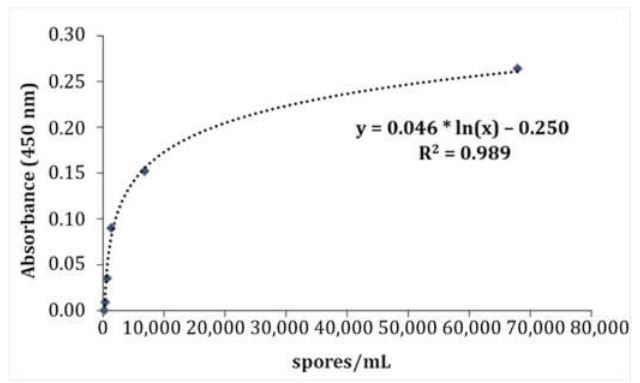
Figure 3. Standard curve developed from fresh B. cinerea conidia, obtained from the relation be- tween conidia concentrations and the generated absorbance values. Dark blue points represent the absorbance value of each concentration point (in spores/mL). Discontinuous line represents the logarithmic curve to which data fitted, defined by the mathematical expression presented in the chart (y, R 2 ).